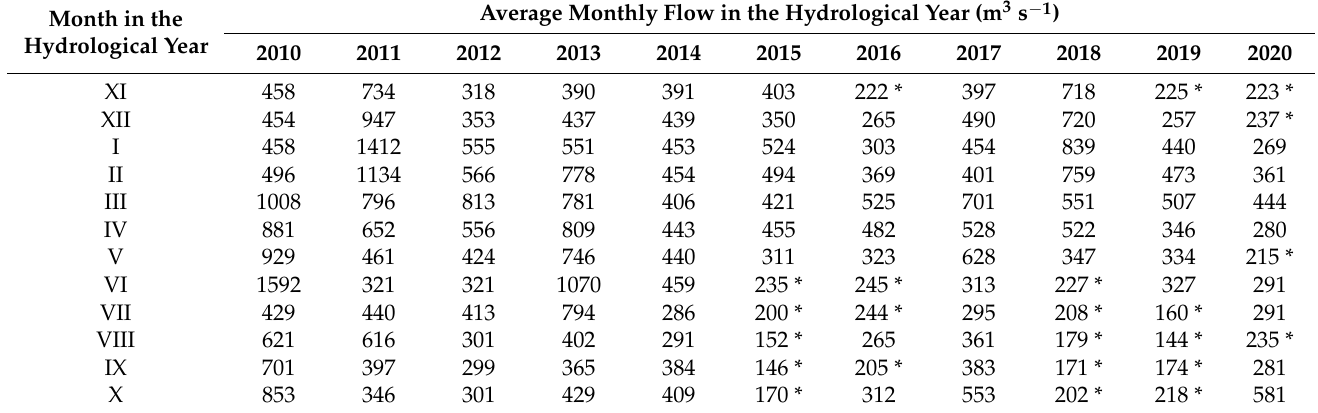
Table 4. Average monthly flows of the Odra River in the estuary profile in 2010–2020